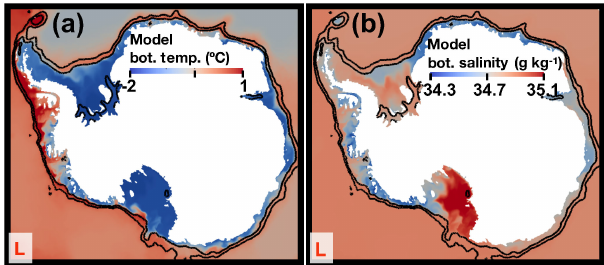
Figure 2. January mean bottom properties for (a) potential temper- ature and (b) absolute salinity for the LMELT (L) case for model year 32. The bathymetry contours of 1000 and 2500m are shown with black lines.